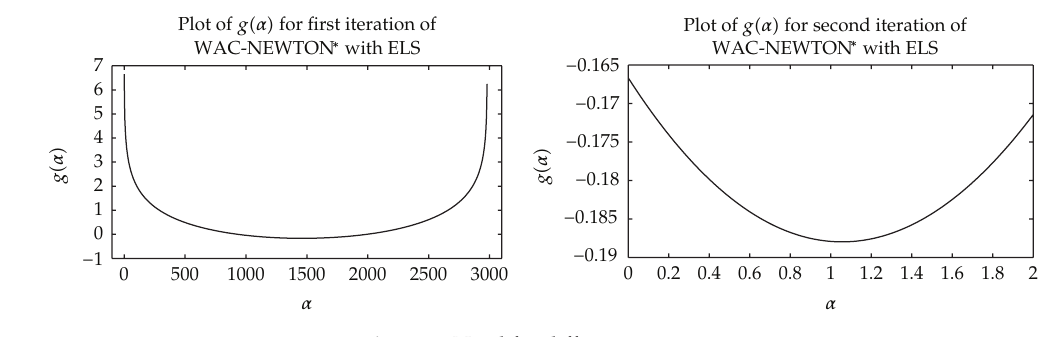
Figure 4: Need for di ff erent